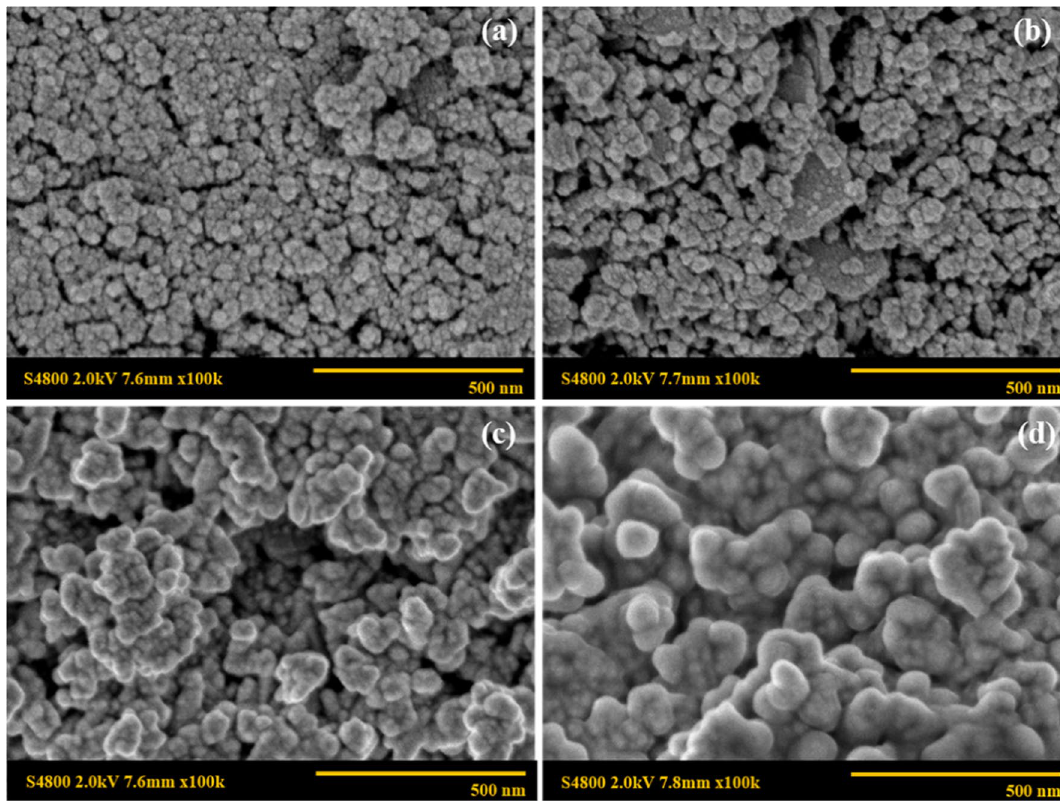
Figure 6. SEM images of CoFe 2 O 4 under various surfactant types: ( a ) CoFe 2 O 4 _ SDS_1CMC; ( b ) CoFe 2 O 4 _ CTAB_1CMC; (c)